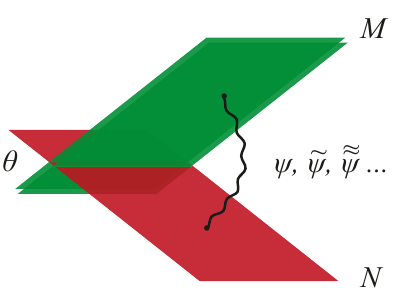
Figure 2 . On each intersection lives a whole tower of states with the same quantum numbers. The lowest mode is typically massless and all the rest are massive, with masses m 2 n = nθ/πM 2 s